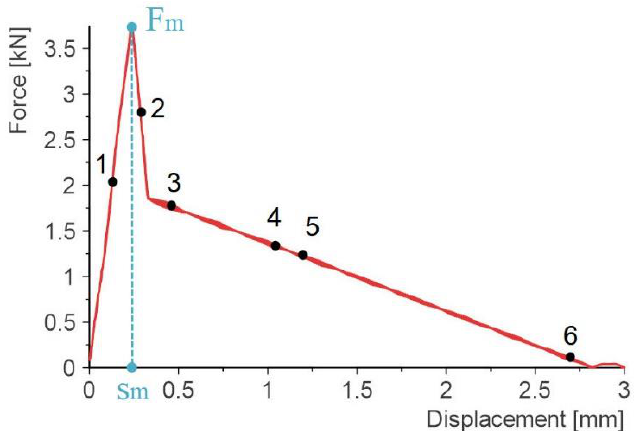
Figure 7. Force displacement graph for model 6.